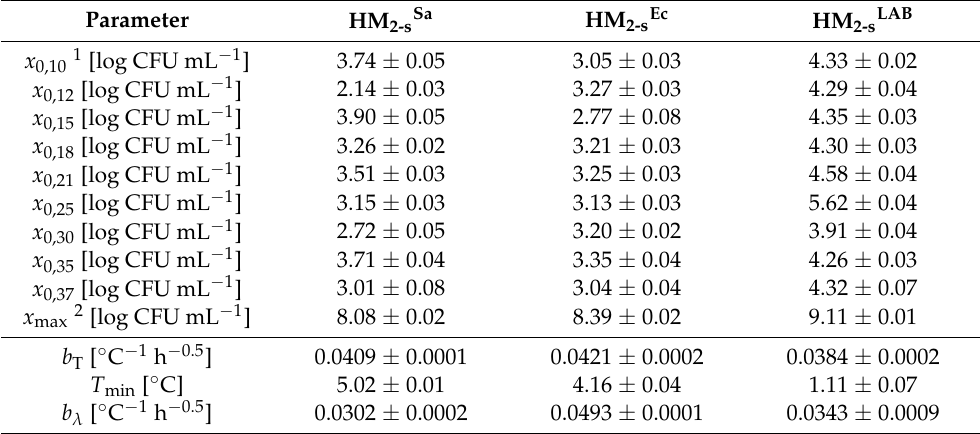
Table 3. Parameters of HM 1-S with a 95% confidence limit determined by the one-step analysis method used for the growth prediction of single cultures of S. aureus (Sa), E. coli (Ec), and Fresco (LAB) in milk.